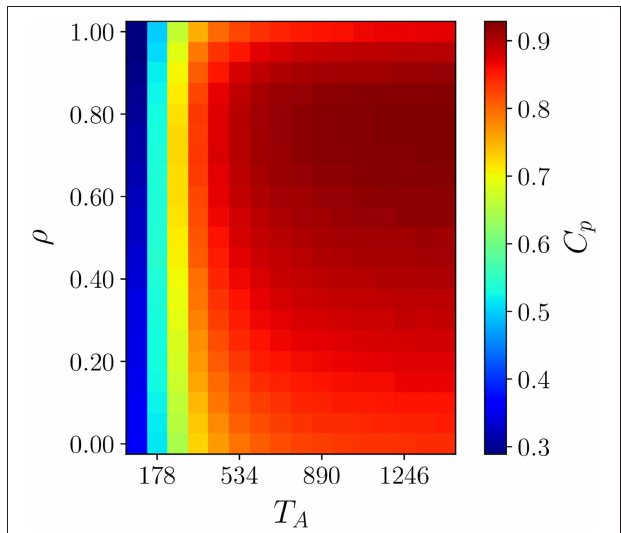
FIGURE 2 | The fraction of the territory defined at time t covered within T A time steps by walkers as a function of the correlation parameter ρ , and the active scent time T A . For each pair of ρ and T A a snapshot average is taken on a thermalized system with L 120 and ν 48. For very low T A the = = territories are highly volatile, i.e., within a T A time window the territories are no longer the ones defined at time t which results in low C p independent of ρ . For higher values of T A the territories are less mobile and we see the maximization of territory coverage for an intermediate values of ρ